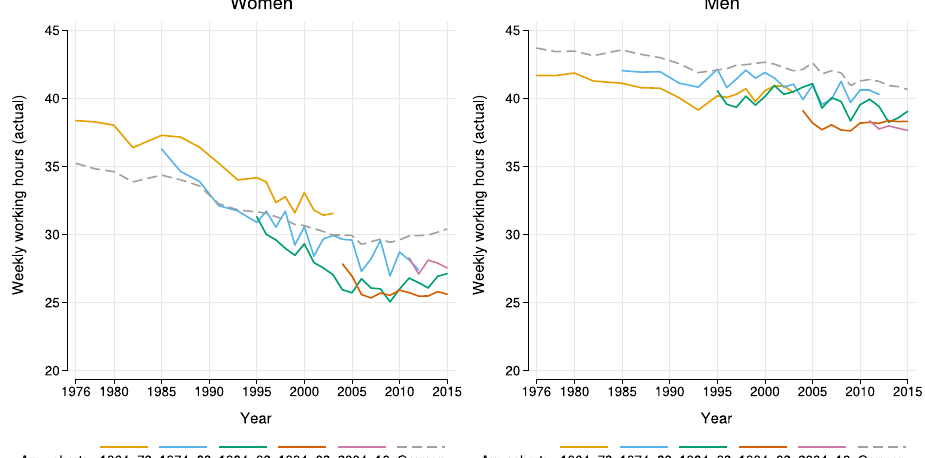
Figure 3 : Weekly working hours by period and arrival